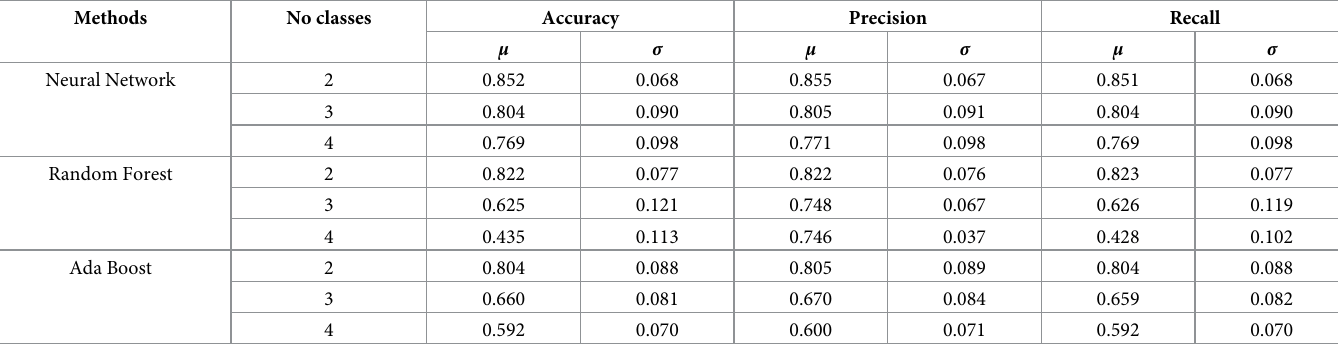
Table 1. Classification results for 2, 3 and 4-class subsets drawn from CIFAR100 dataset.